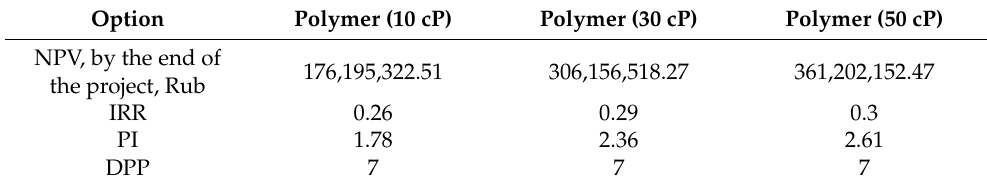
Table 5. Key economic indicators for polymer solutions of different